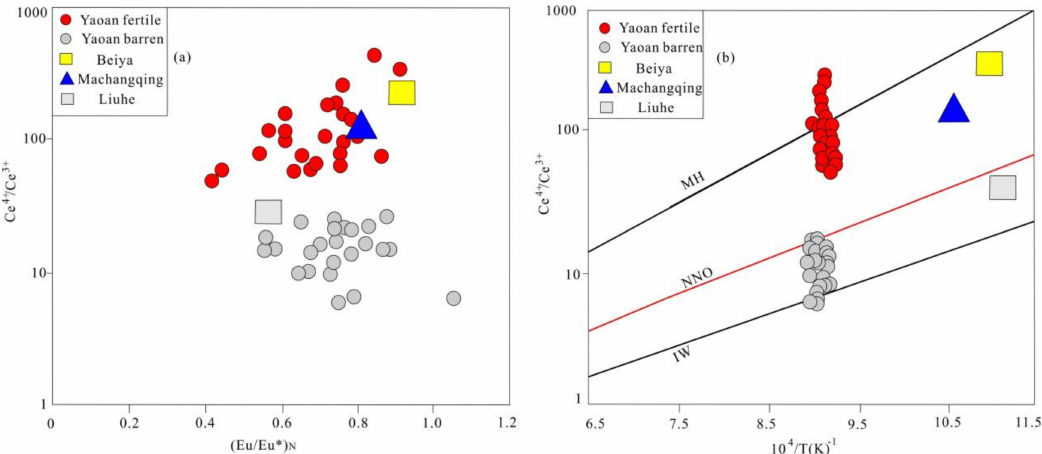
Figure 12. ( a ) Plots of δ Eu vs. Ce 4+ /Ce 3+ in zircon. ( b ) Plots of Ce 4+ /Ce 3+ vs. 10 4 /T in zircon. High Ce 4+ /Ce 3+ ratio signifies high oxygen fugacity. The Yao’an data are compared with those from the Beiya porphyry [6], Machangjing porphyry [32], and Liuhe porphyry [39], using the equation of